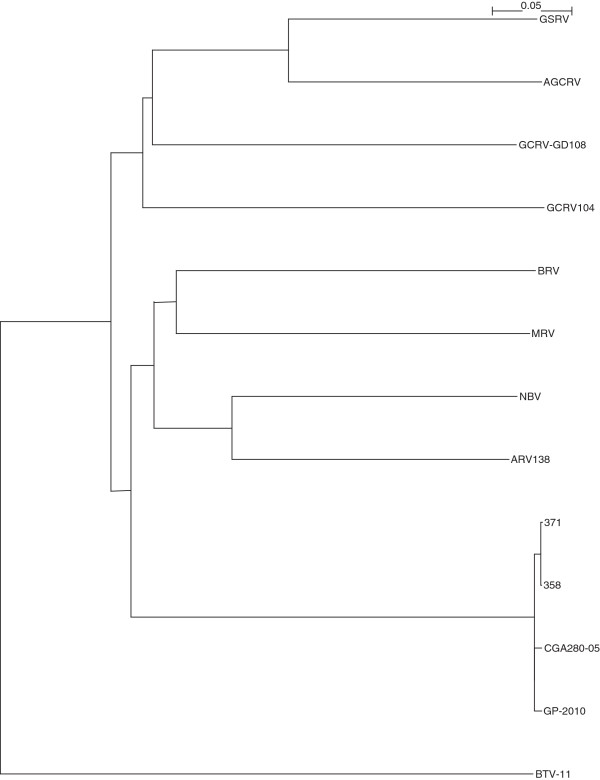
Phylogeny of homologous segment L3 shared by piscine reovirus (PRV) and selected members of familyReoviridae.